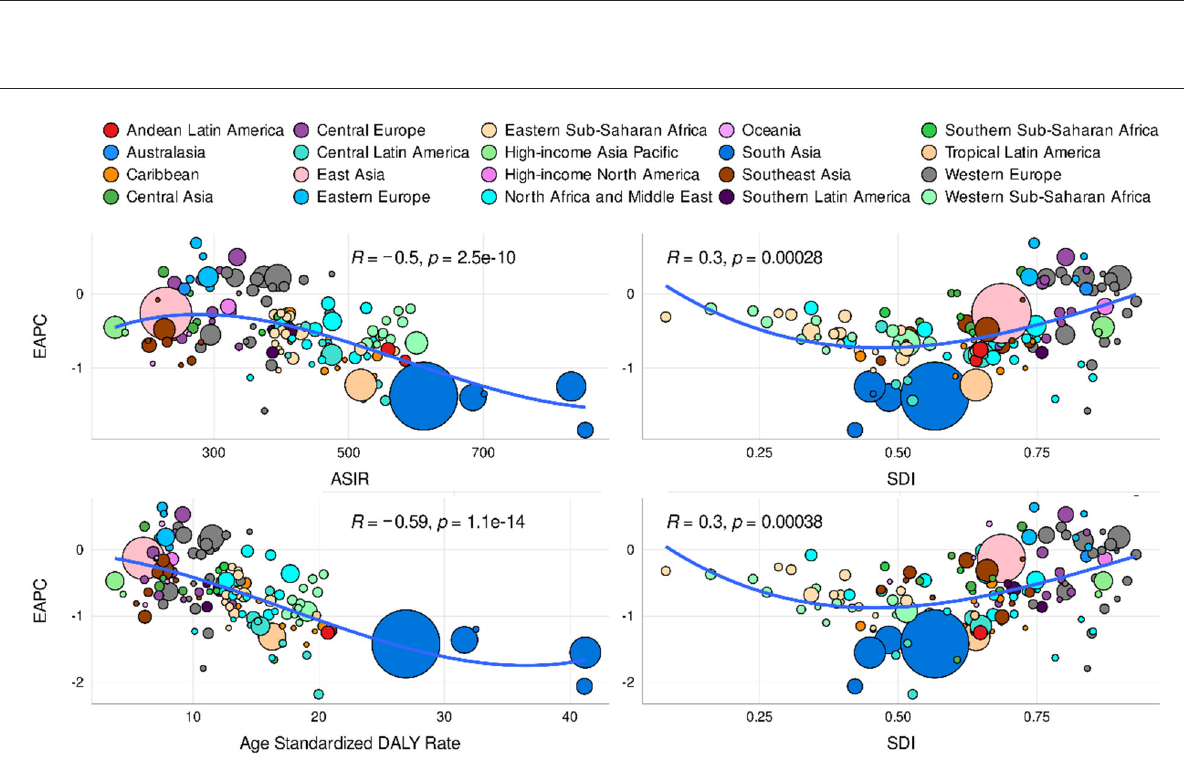
FIGURE4 Correlation analysis of different SDI regions, age-standardized DALYs and EAPC of global POP from 1990 to 2019.